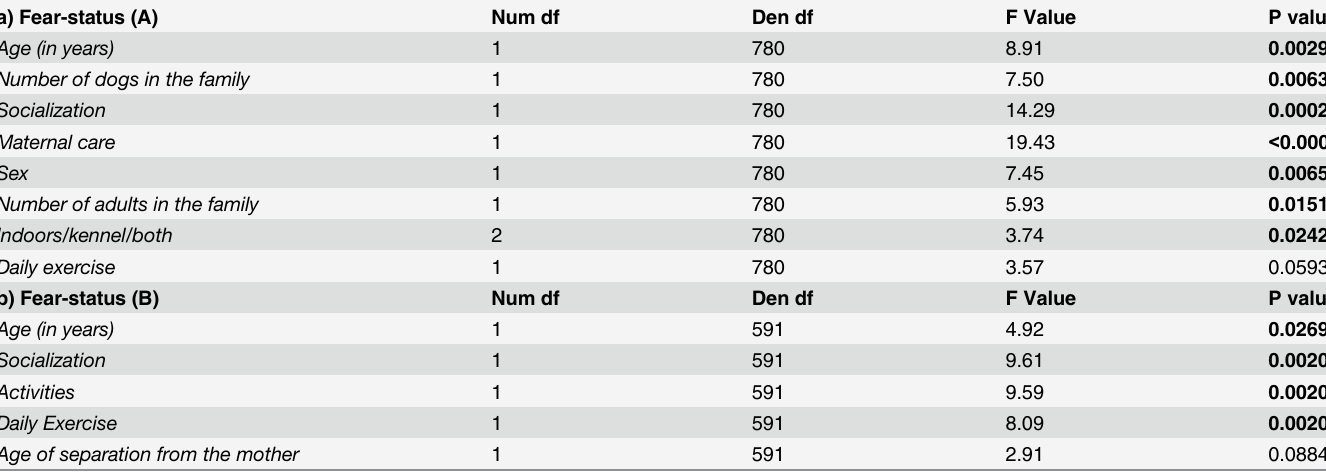
Table 2. Generalized linear mixed model analysis results on the association between environmental factors and